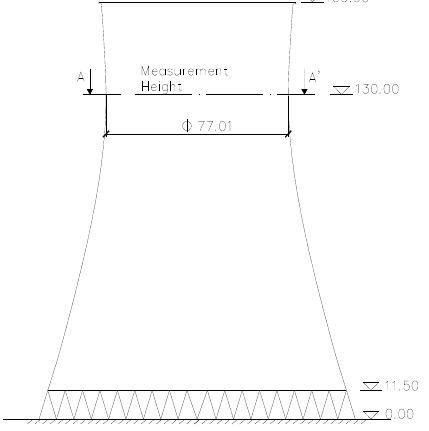
Figure 4. Projection of measuring tower (unit: m).